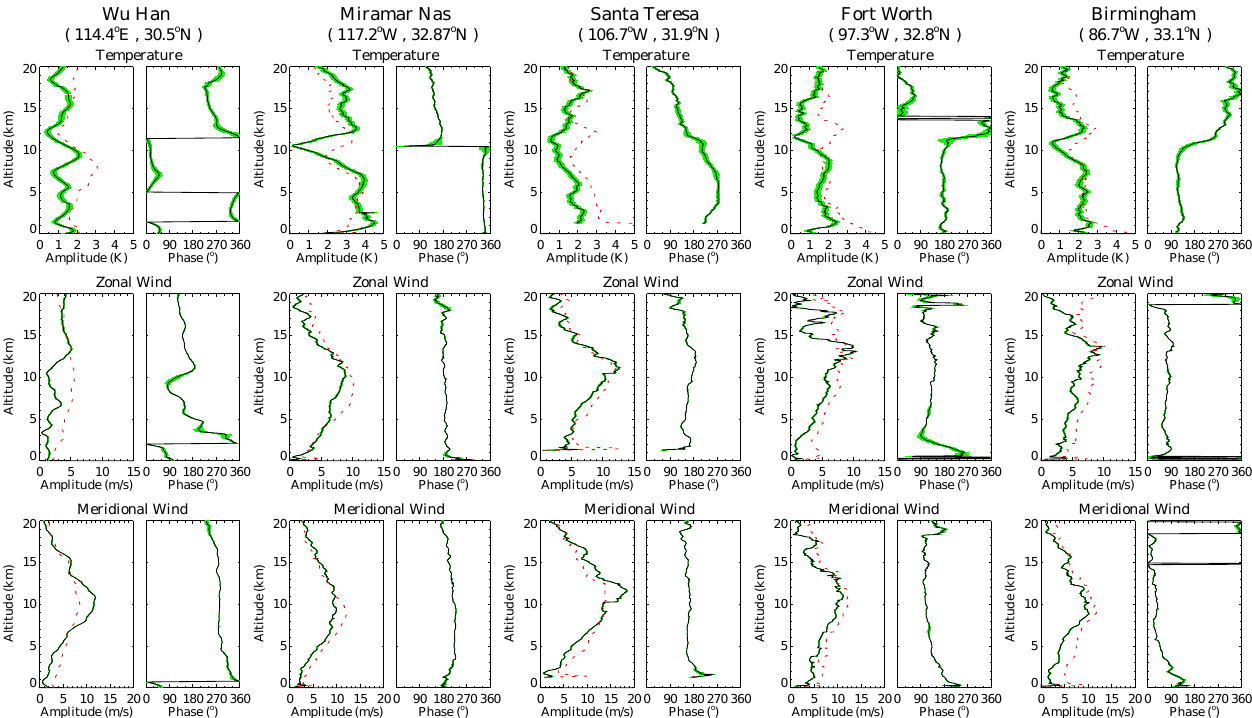
Fig. 8. The harmonic fitting results for the quasi 16-day waves of the temperature, zonal and meridional wind disturbances during 15 Jan- uary 2001 to 15 February 2001 in the height of 0–20km. The green lines in every 100m in height denote the error bar.